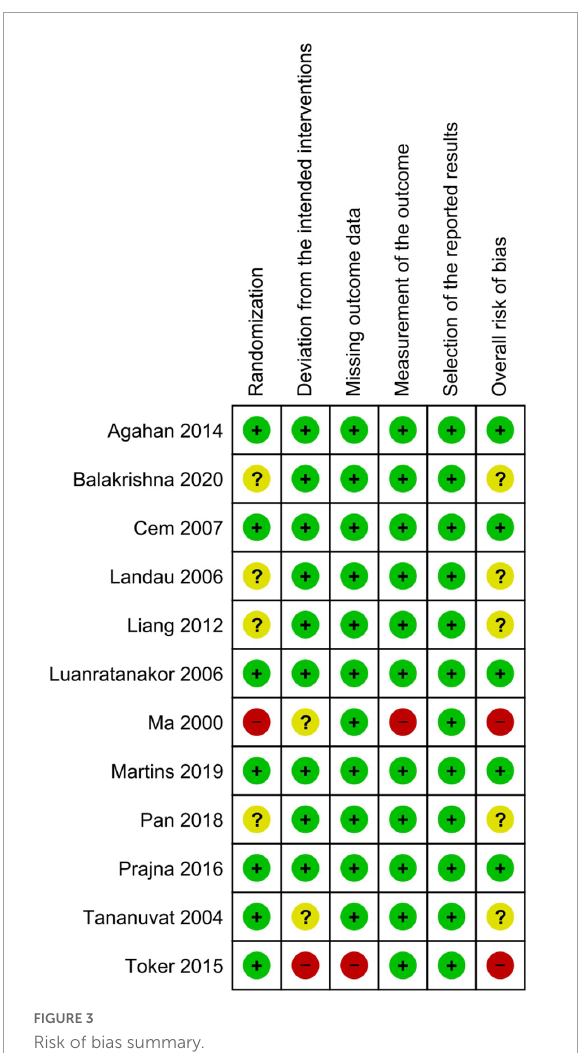
FIGURE3 Risk of bias